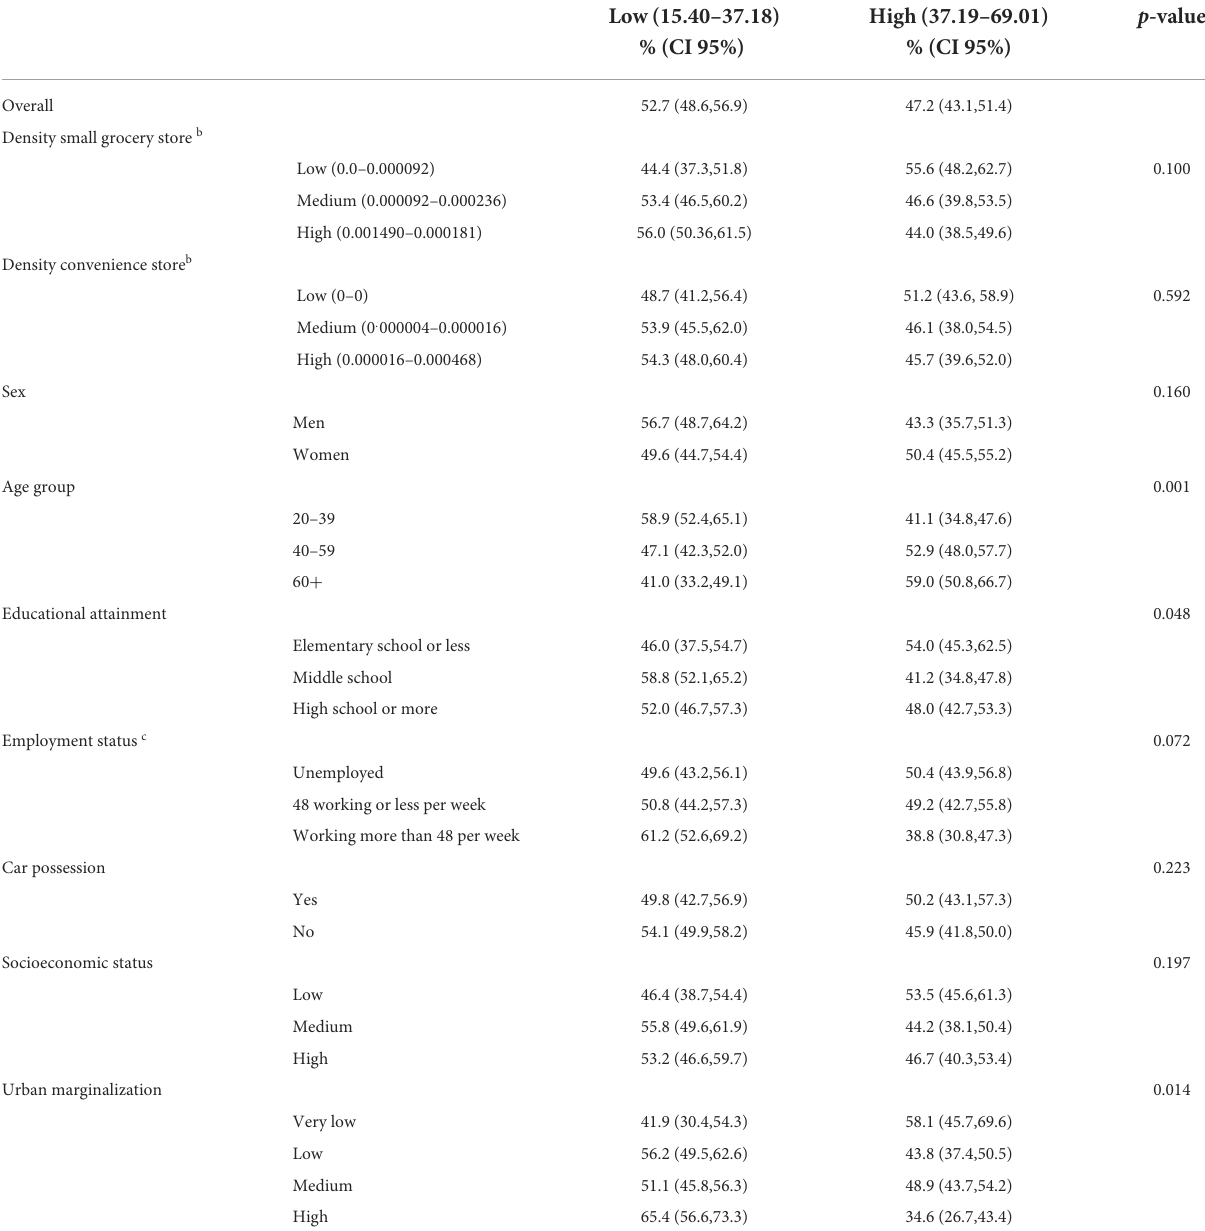
TABLE 2 Mexican Alternate Healthy Eating Index scores by participants’ characteristics.